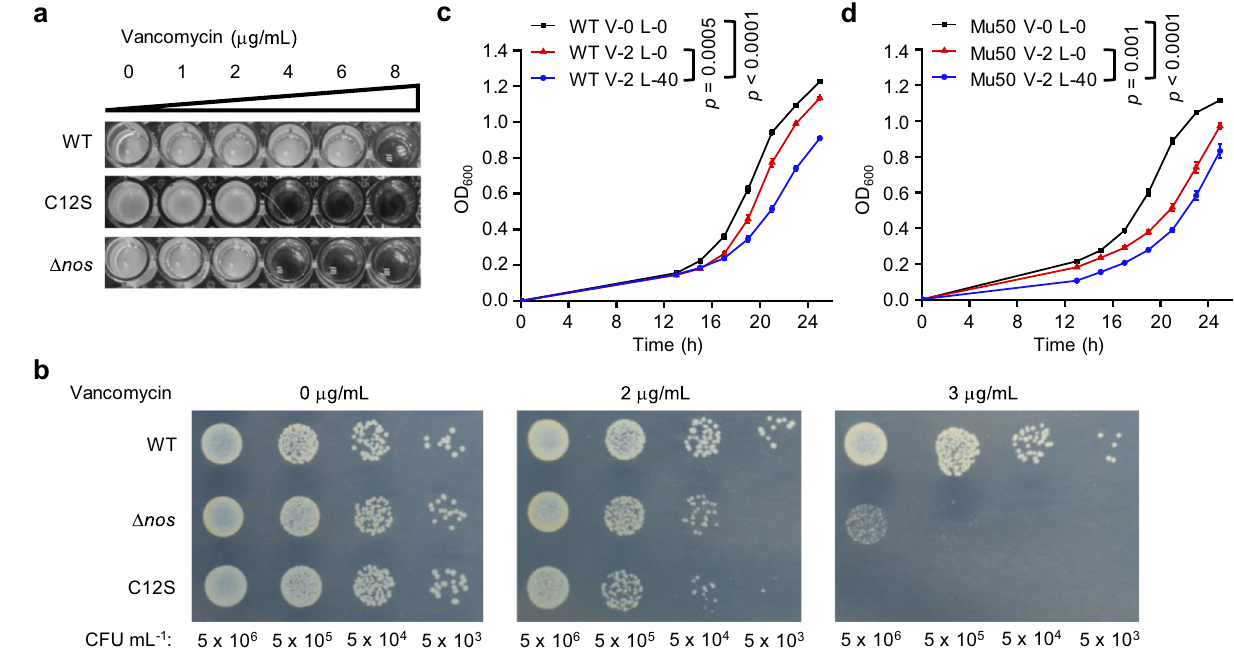
Fig. 2 | NO-mediated MgrA S-nitrosylation promotes the resistance of VISA to vancomycin. a MICs were assessed after the WT S. aureus XN108, mgrA C12S mutantand Δ nos mutantstrainsweregrownundervancomycinconditionsina96- wellplatewithshakingat200rpmfor48hat37°C.Dataarerepresentativeof n =3 biologicalreplicates. b Thegrowthofallthestrainsonnormalconditionormedium with different concentrations of vancomycin as indicated on agar plates was measured by a plate-sensitivity assay. Data are representative of n =3 biological